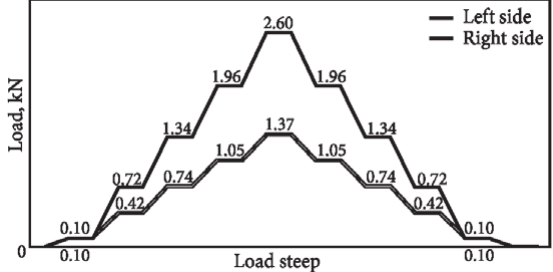
Fig. 4. Loading history of the analytical asymmetric load